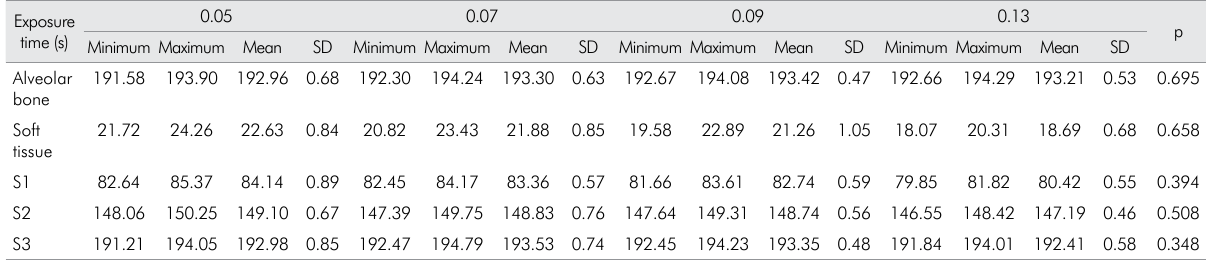
Table 1. Comparison of the gray values in the various exposure times and ROIs (ANOVA). Exposure time (s)